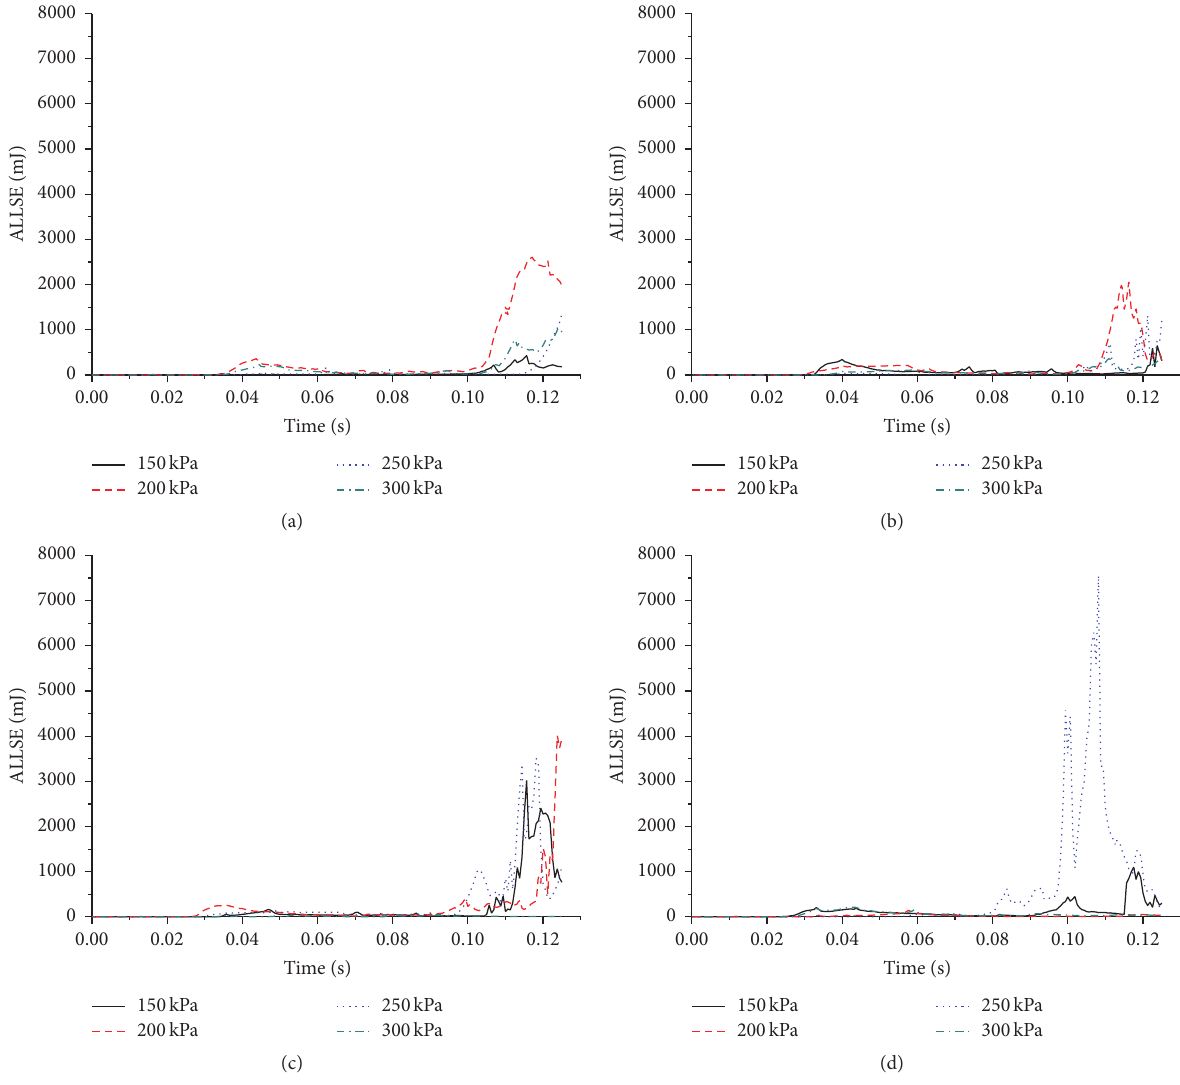
Figure 6: Curves of ALLSE under different processing parameters in AFP process: (a) laying speed of 27m/min; (b) laying speed of 30 m/min; (c) laying speed of 33 m/min; (d) laying speed of 36